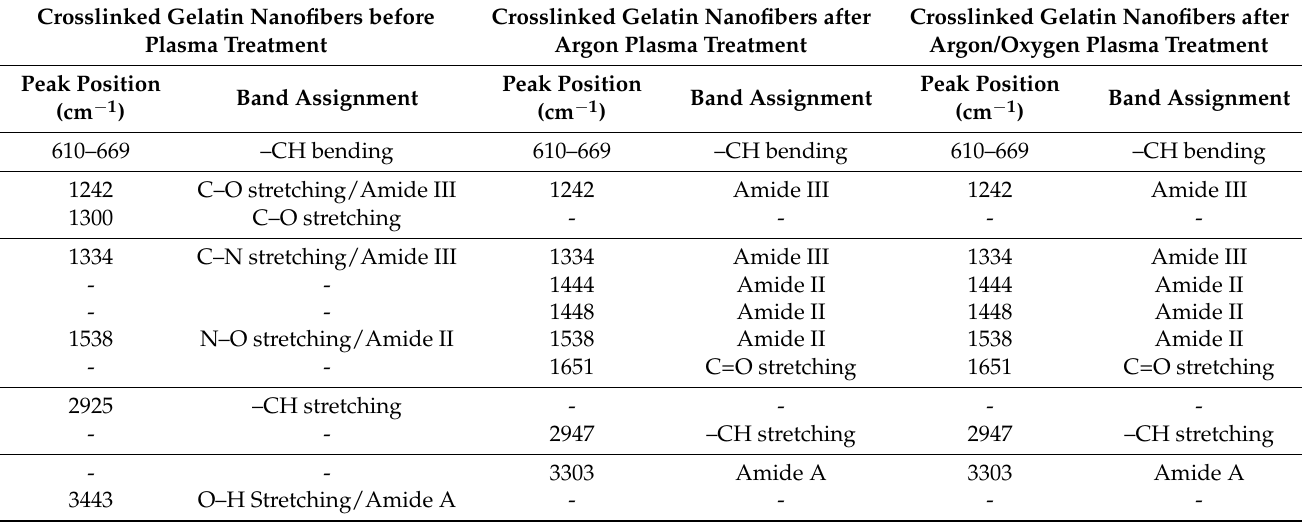
Table 2. The main ATR-FTIR peaks observed in crosslinked gelatin nanofibers before and after plasma treatment. Crosslinked Gelatin Nanofibers before Crosslinked Gelatin Nanofibers after Crosslinked Gelatin Nanofibers Plasma Treatment Argon Plasma Treatment